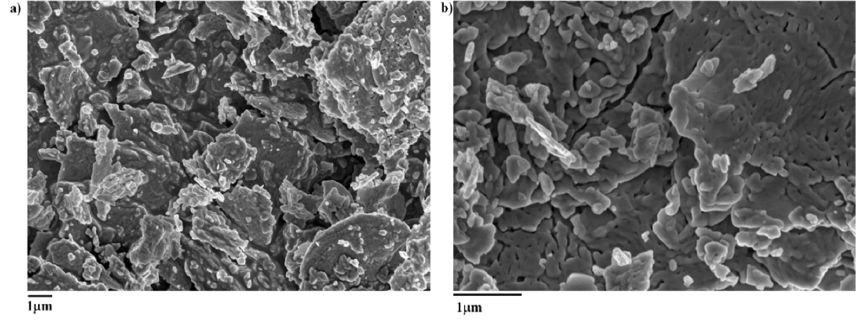
Figure 2. FE-SEM images of freshly synthetized Bi 2 O 3 at different magnifications (( a ) 5K, ( b ) 10K).